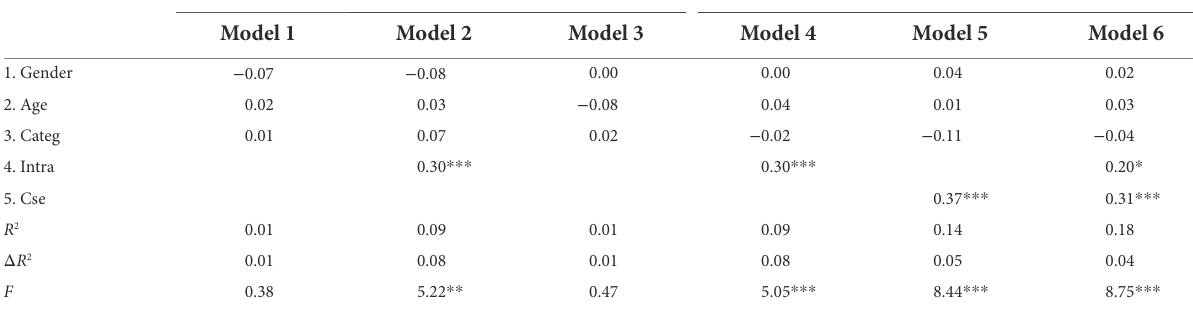
TABLE 5 Results of the mediating effects of creative self-efficacy.